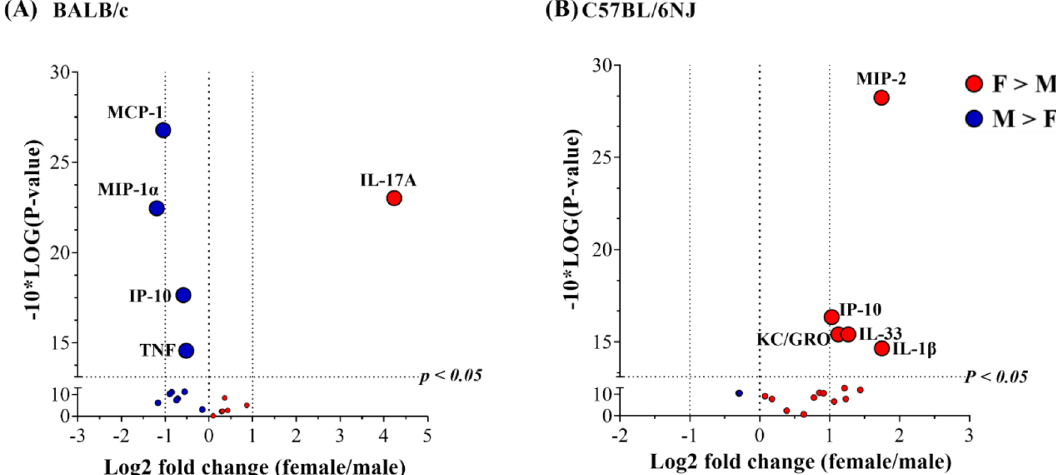
Figure 4. Sex-related differences in HDM-mediated secreted cytokines in BALF. ( A ) BALB/c mice (n = 9 each, of females (F) and males (M), per group) and ( B ) C57BL/6NJ mice (n = 10 each, of females and males, per group) were challenged (i.n) with 35 μL of 0.7 mg/mL whole HDM protein extract in saline per mouse, once daily for five consecutive days with a 2 day rest in between for 2 weeks. A panel of 29 chemokines and cytokines were measured in BALF collected 24 h after the last HDM challenge, by multiplex Meso Scale Discovery (MSD) platform. The ratio of concentration of each cytokine in the BALF of each HDM-challenged mouse compared to the mean concentration obtained from the group of naïve mice represents the HDM-driven fold change (HDM/ naïve). Log2 values of average HDM/naïve fold change obtained from female and male BALF were used for the volcano plots. Positive values on the x-axis of the volcano plots (shown in red) are cytokines that are significantly higher in females compared to males, and negative values (shown in blue) are those that are significantly higher in males. Dotted lines represent a fold change of 2 (x-axis) and p < 0.05 (y-axis).